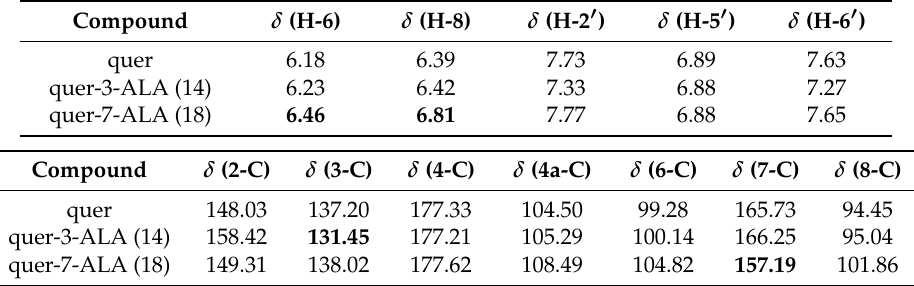
Table 1. Chemical shifts ( δ ) of the aromatic protons and carbons of natural quercetin [41] ( quer ), quer-